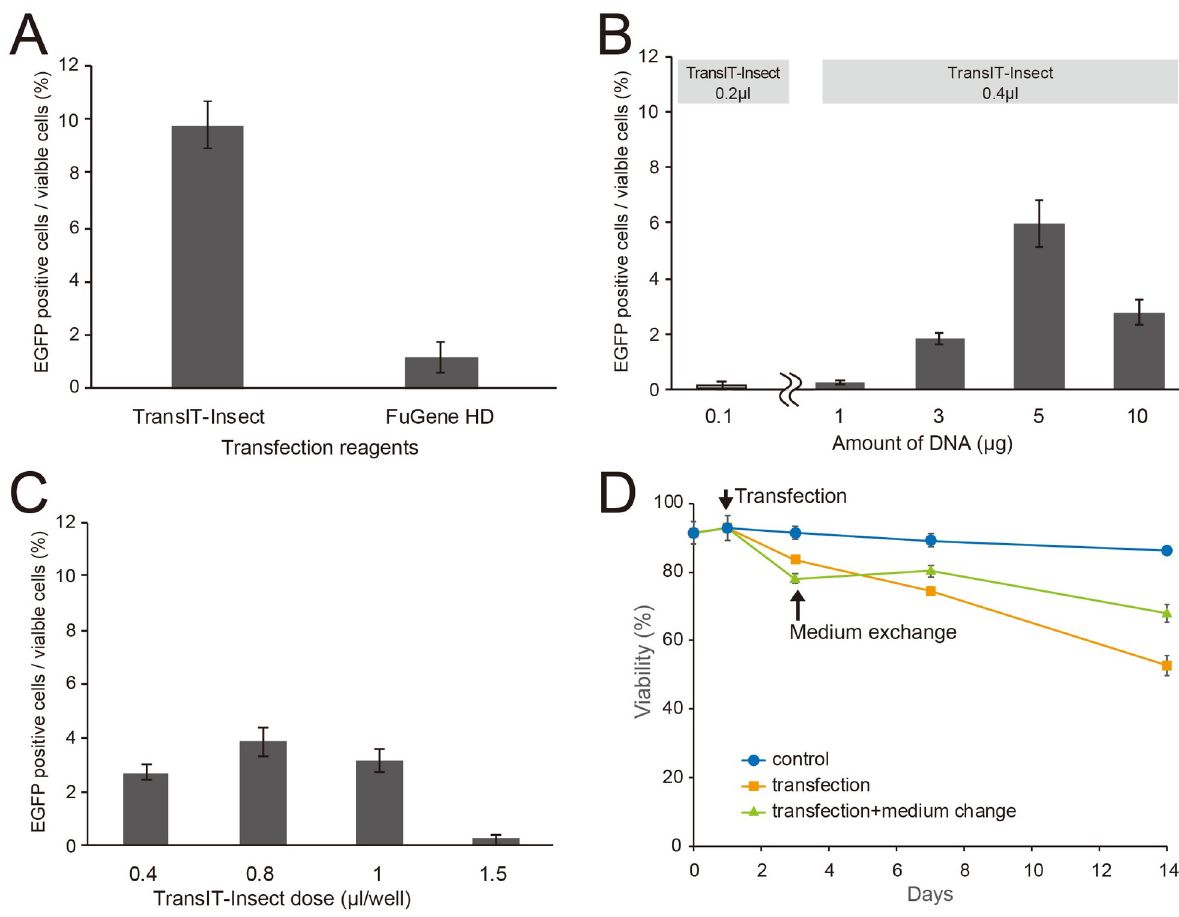
Fig 7. Selection of optimal conditions for the induction of gene expression. A . Comparison of transfection reagents. B . The optimal amount of vector plasmid DNA to be transfected was 5.0 μ g/well when 0.4 μ l/well of the TransIT-Insect reagent was applied. The graph on the left shows transfection efficiency when the conditions recommended by the supplier were employed. C . The optimal dose of the transfection reagent was 0.8 μ l/ well when 5.0 μ g/well of plasmid DNA was applied. D . Effects of medium exchange after transfection on cell viability. Error bars indicate the standard error of the mean of three